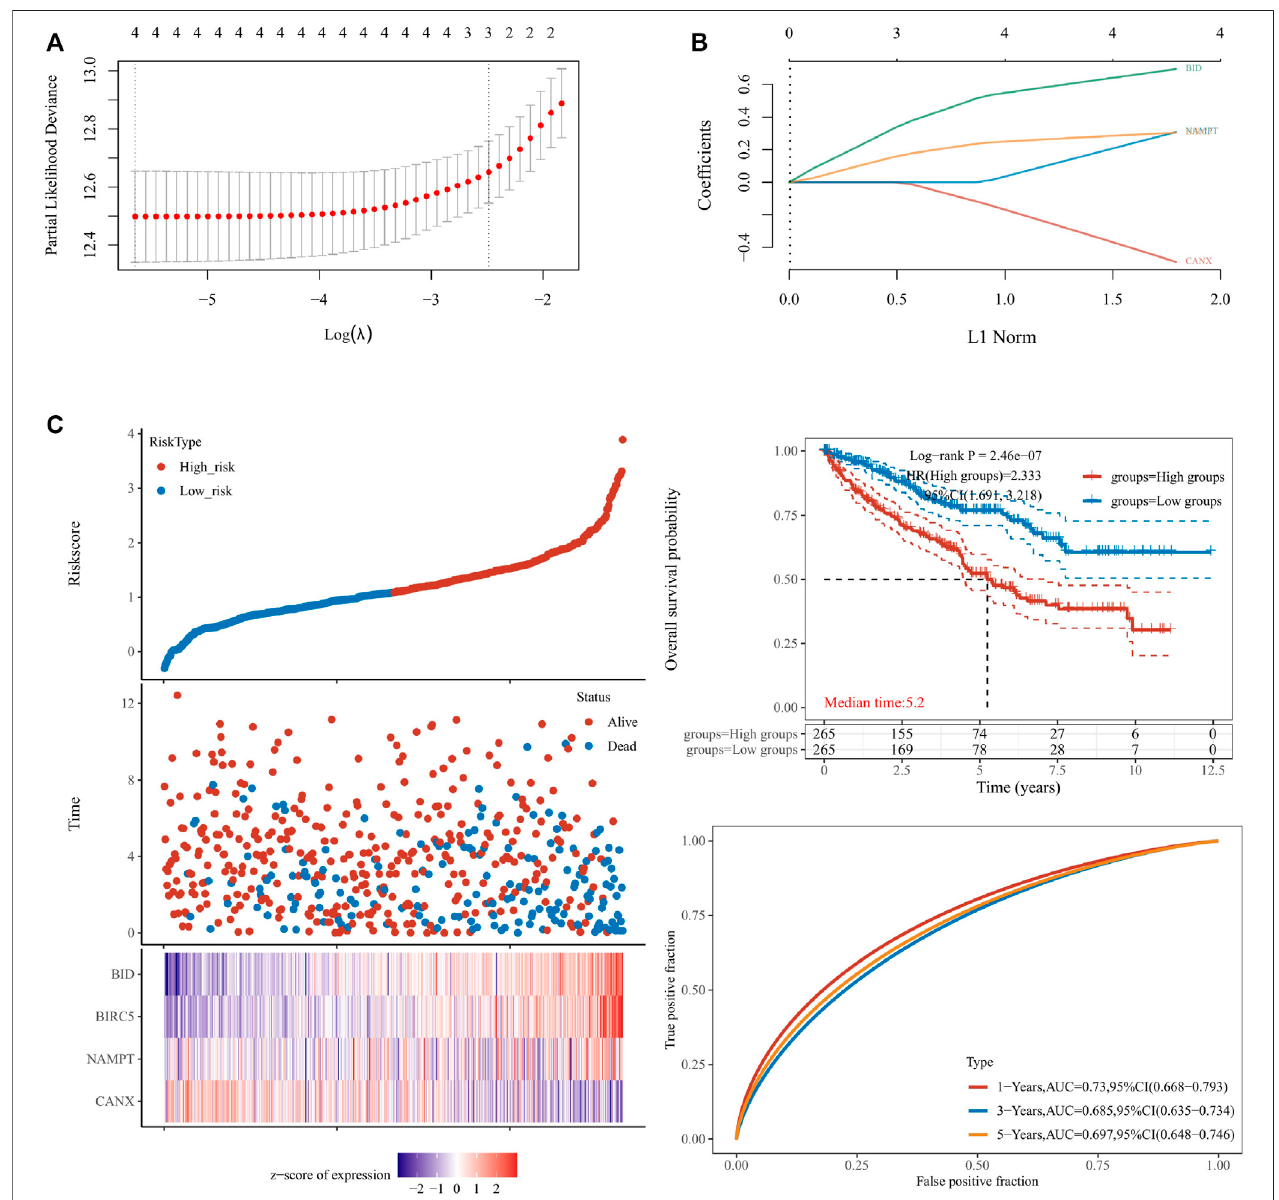
FIGURE4| Construction ofaprognosticmodel fortherisks associated withdifferentially expressed genes(DEGs).The calculationsforthe modelaccordingto the multivariateCoxregressionanalyses (A,B) .Theprognosticmodelwasanalyzedbysurvivaltime,survivalstatus,targetgeneexpressionheatmap,and1/3/5-yearoverall survival (C) . lambda.min (cid:1) 0.0035. Riskscore (cid:1) ( − 0.4879) * CANX + (0.3075) * NAMPT + ( − 0.3041) * BIRC5 + (0.694) * BID.